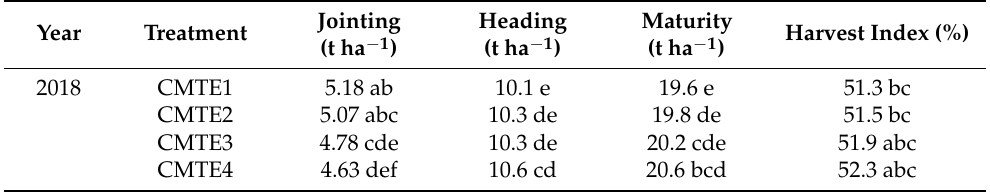
Table 6. Dry matter weight and harvest index of rice under different mechanical transplanting methods and planting